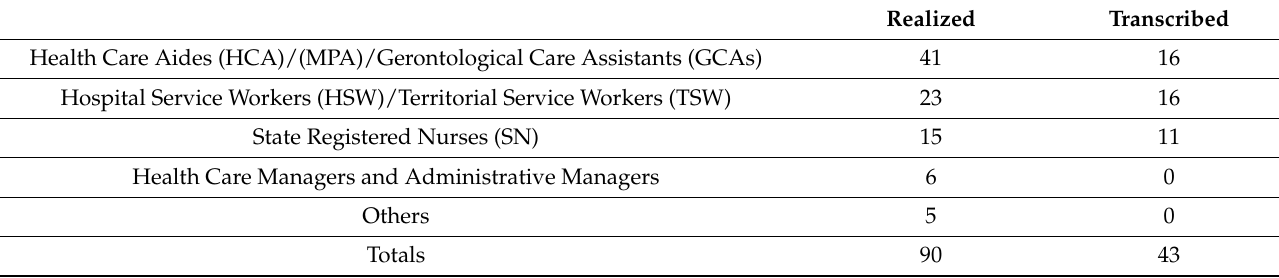
Table 2. Distribution of interviews classified by